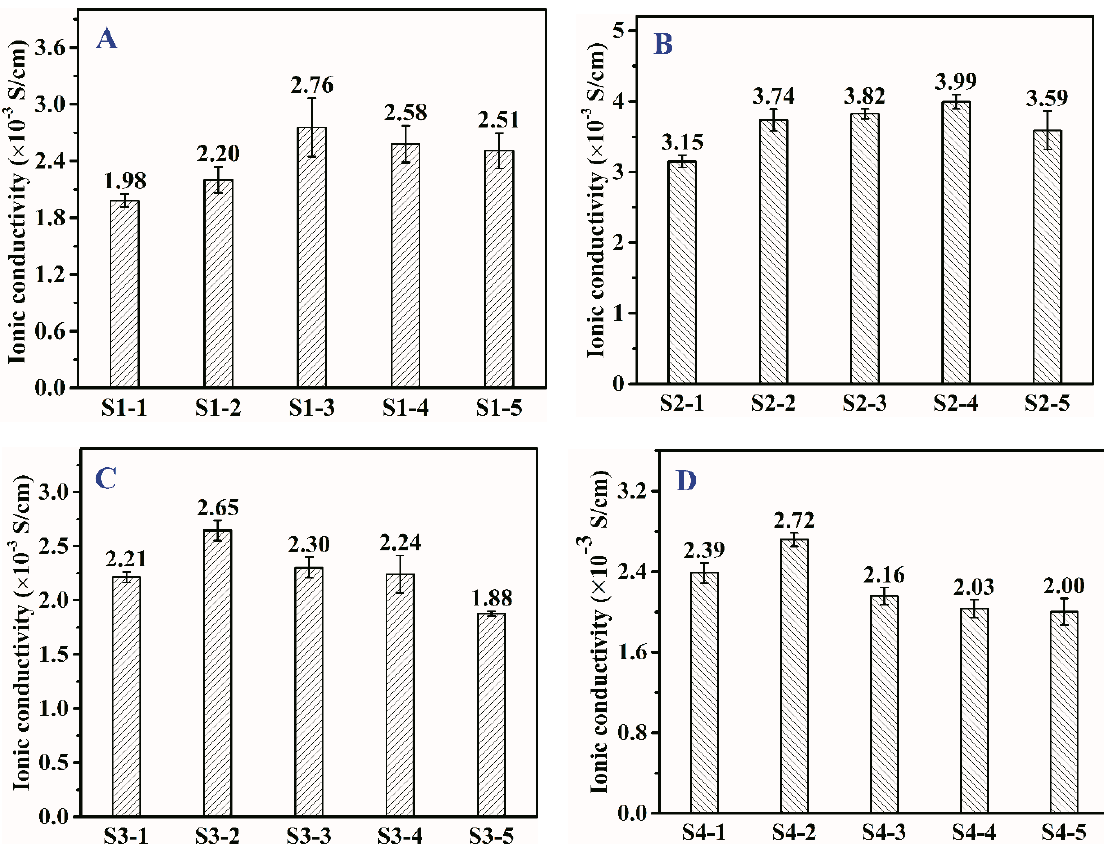
Figure 4. Ionic conductivities of GPEs prepared by different mixed solvents. ( A ), S1; ( B ), S2; ( C ), S3; ( D ), S4.